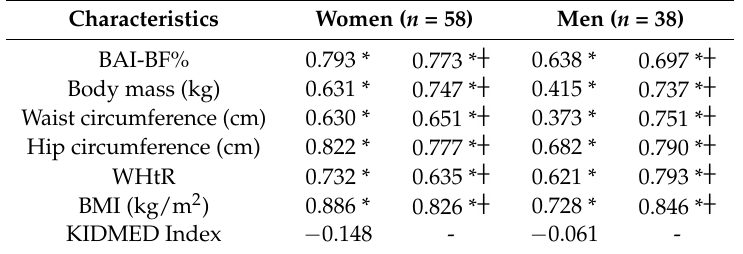
Table 2. Pearson’s correlation coefficients between BF% determined by BIA and different variables.